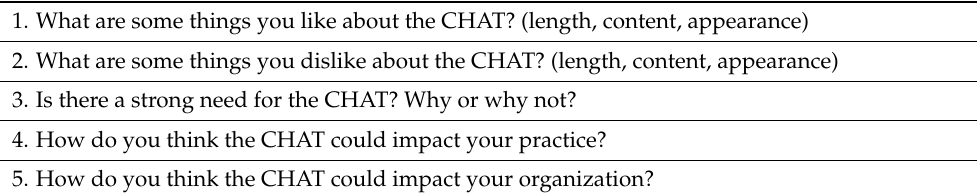
Table 1. Example healthcare administrator and practitioner interview